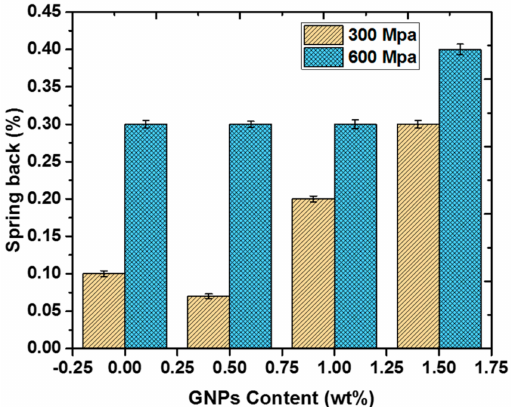
Figure 14. Spring back effect of the various GNPs content in Al compacts at 300 and 600 Mpa